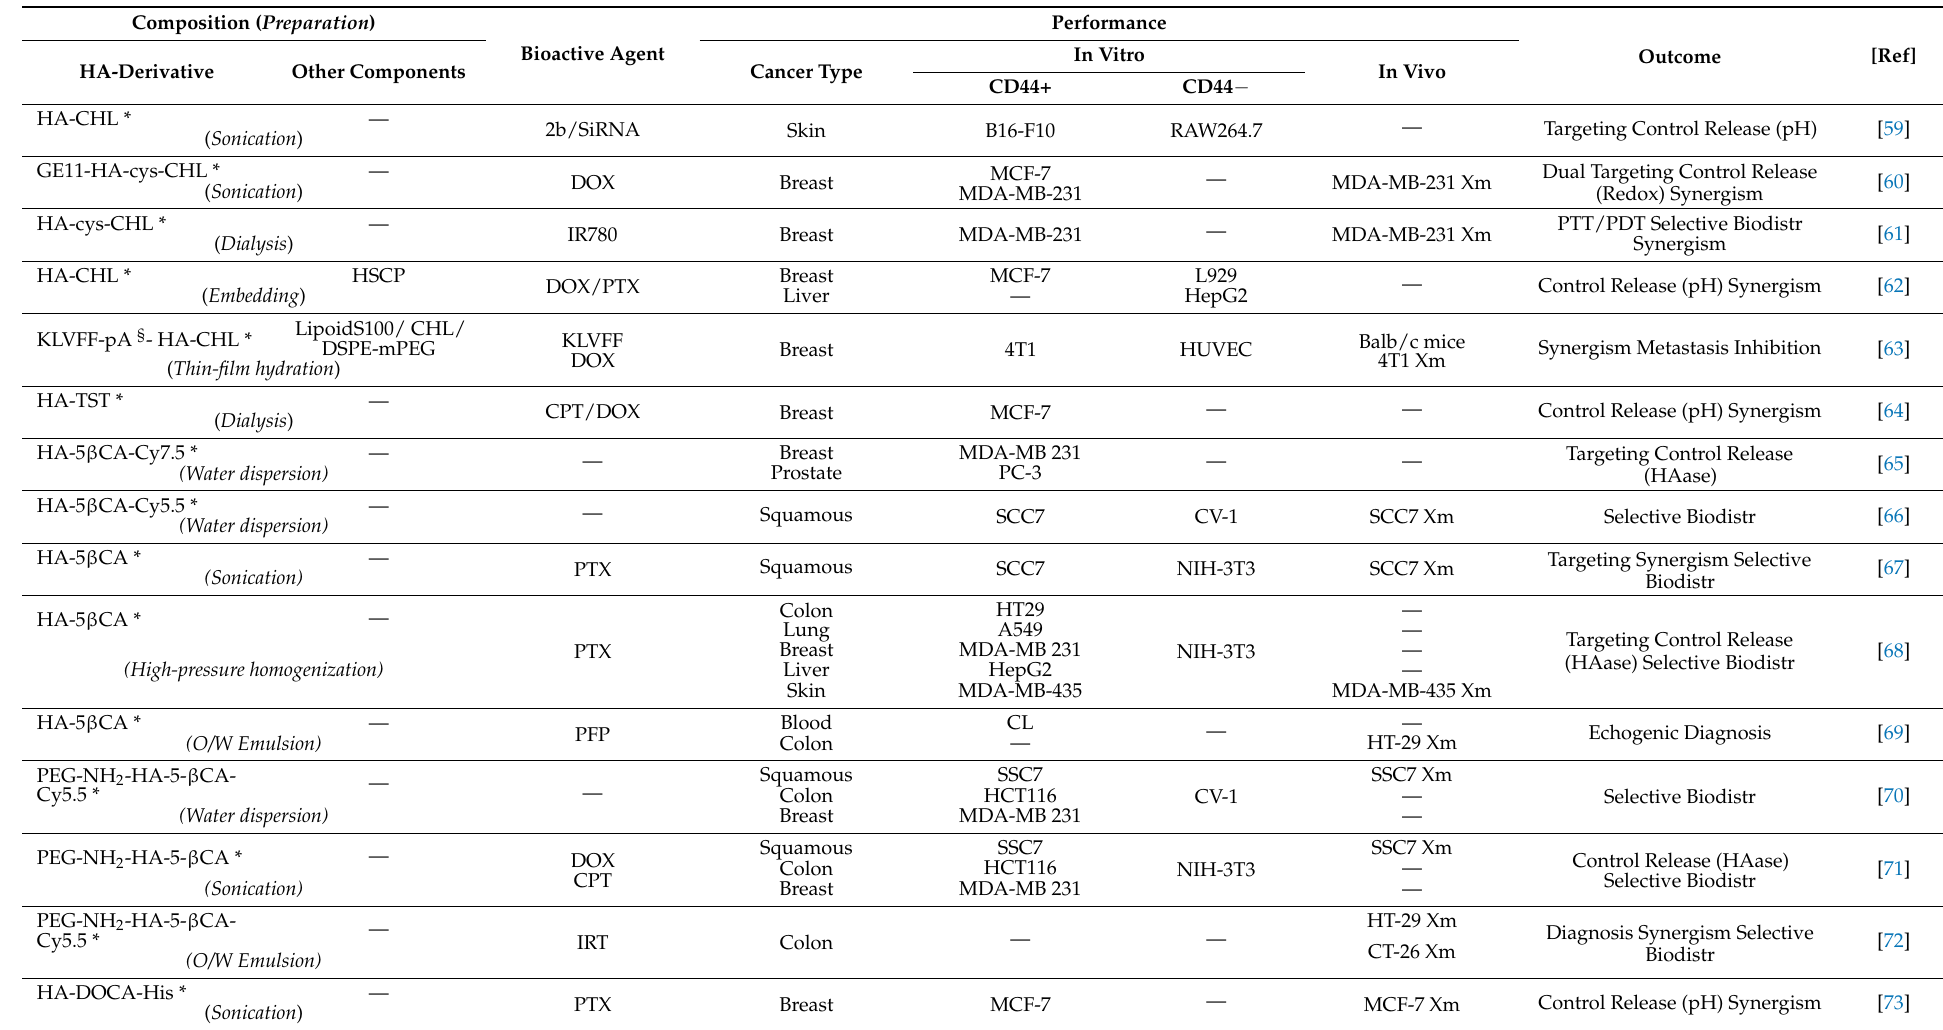
Table 2. HA-SANPs obtained by hydrophobic interactions of steroid-modified